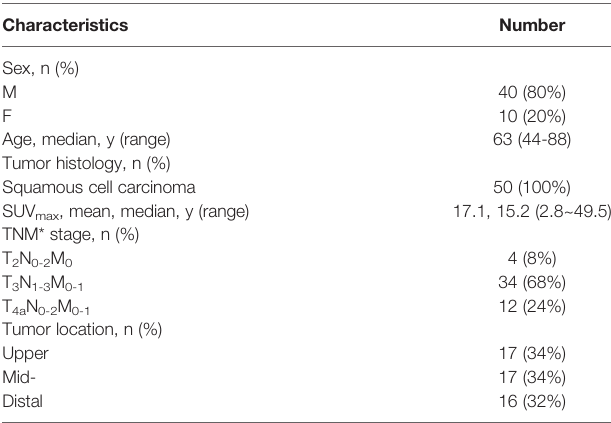
TABLE 1 | Patient ’ s